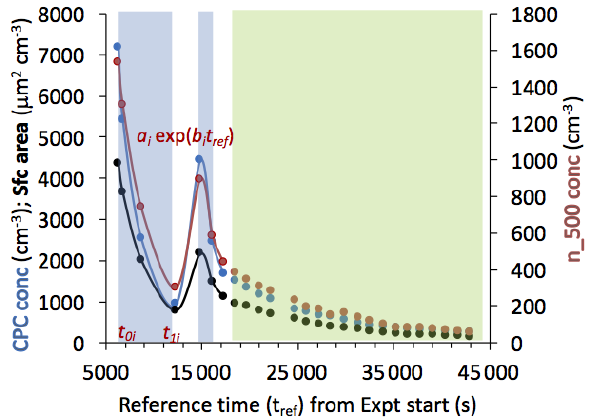
Figure 3. Data from the first half of a daily experimental series, af- ter an initial fill of Tunisian soil dust (Experiment 11 and 12 of the FIN-02 APC series on 18 March 2015) into the APC at a time (time 0) taken to be the experimental start time. Impinger and filter sam- ple periods after two separate chamber fills are highlighted in light blue shading. To obtain a reference aerosol concentration (cm − 3 ) via the CPC (total particles) (blue points, left scale) or optical parti- cle counter at sizes larger than 500 nm ( n _500; brown points, right scale), as well as surface area (µm 2 cm − 3 ) (black points, left scale) for the impinger/filter sampling period, the time-weighted average of the two sampling periods was determined. This period-integrated concentration value could then be used as a numerator in a ratio over the concentrations of particles present at later sampling times (Eq. 3) during the direct processing instrument sampling of aerosols from the APC (green shaded region) in order to back-correct the di- rectly sampled INP number concentrations to those derived for the collections for post-processed